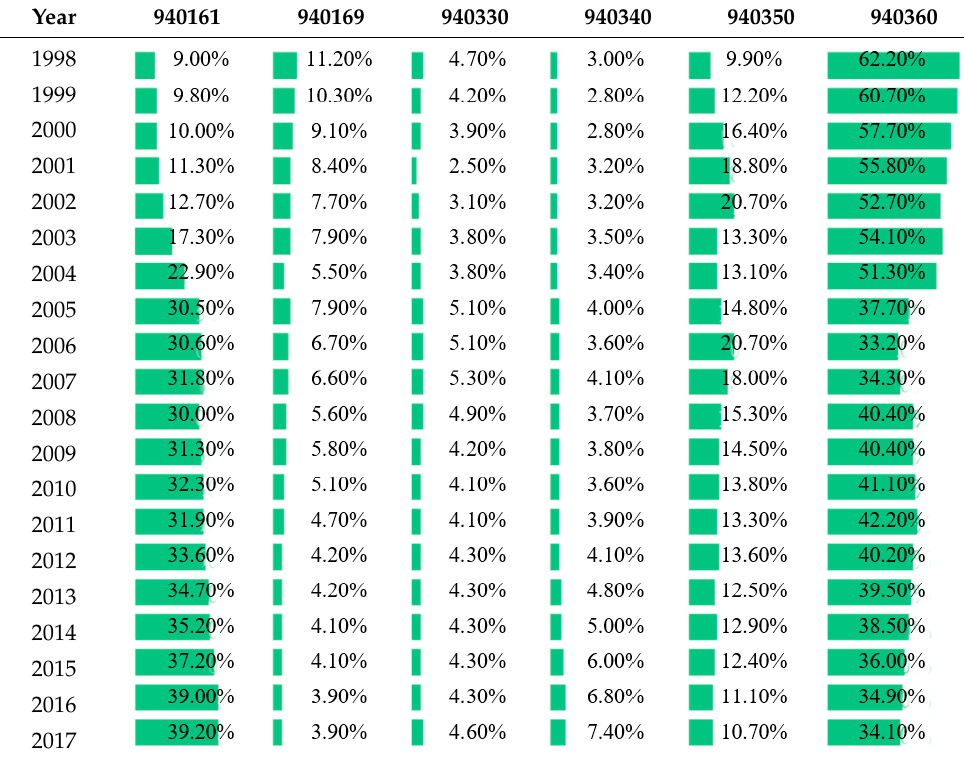
Table 6. Export value share of wooden furniture products by HS 6-digit category.